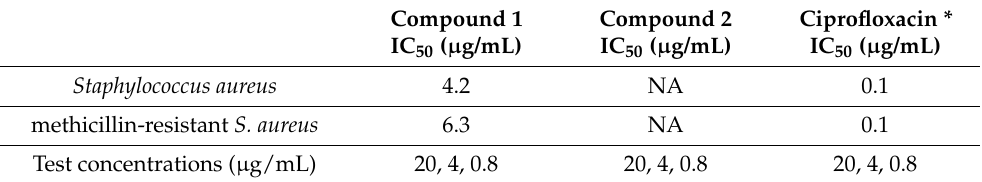
Table 2. Antibacterial activity of compounds 1 and 2 .